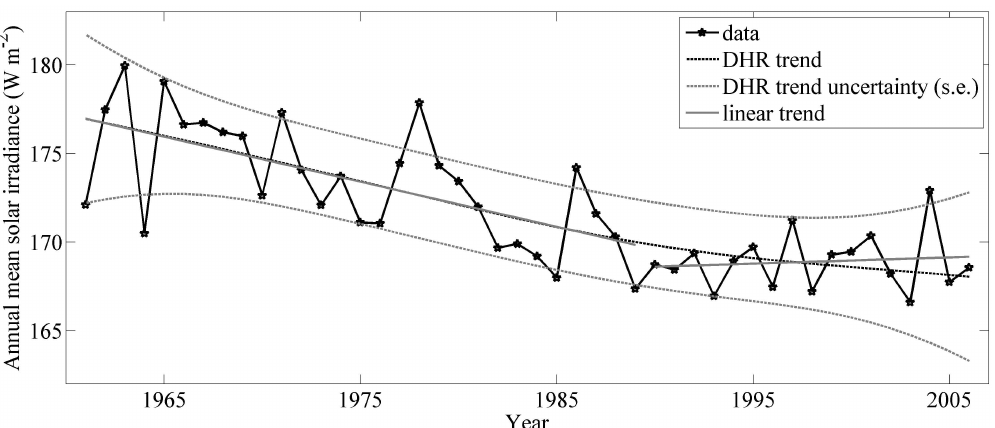
Fig. 10. Comparison of the solar radiation trends derived from the linear regression with that derived from the DHR method. The time series are derived from the annual mean solar irradiance averaged over all CMA stations during 1961 ∼ 2006. “s.e.” denotes standard deviation of the trend estimate, and uncertainty is given at 90% confidence